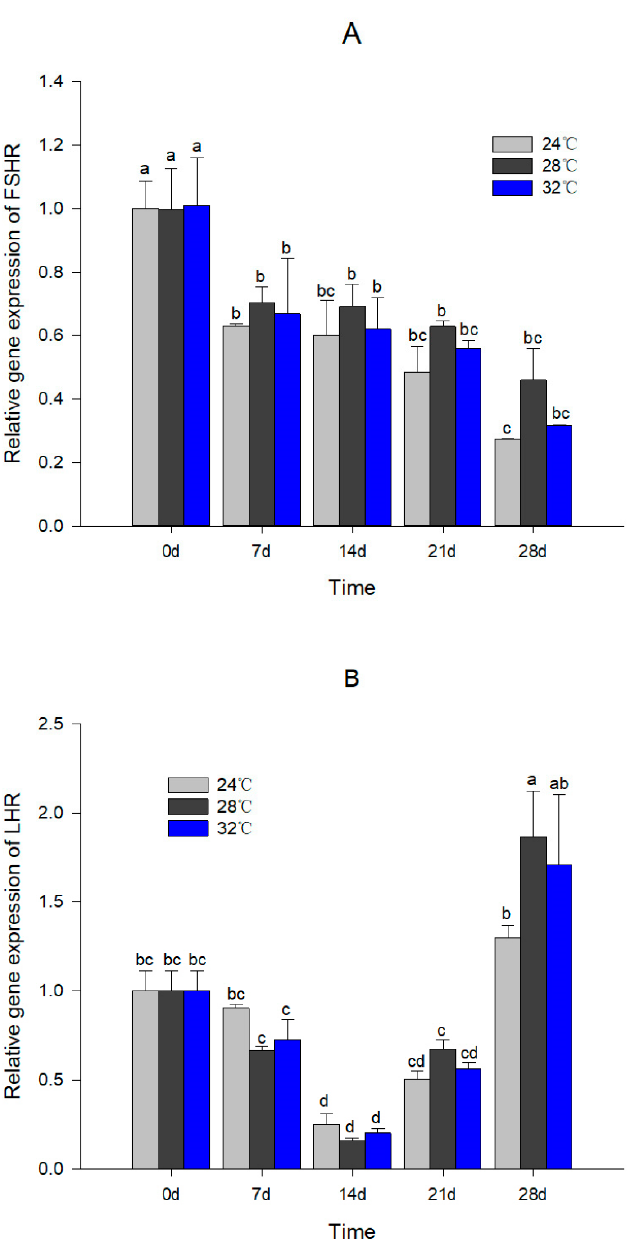
Figure 4. Expression analysis of FSHR gene ( A ) and LHR gene ( B ) in testis after different temperature treatments. Note: Different lowercase letters represent significant differences between the experimental groups at various time points ( p < 0.05); Reference gene: β-actin ; n = 3.